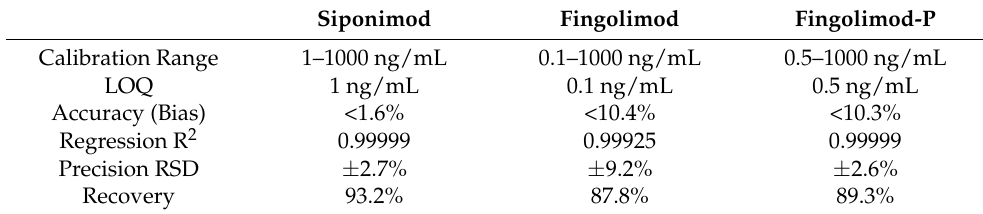
Table 3. Quality parameters used for mass